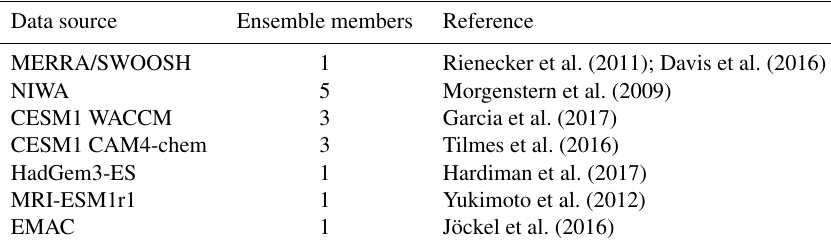
Table 1. The data sources used in this